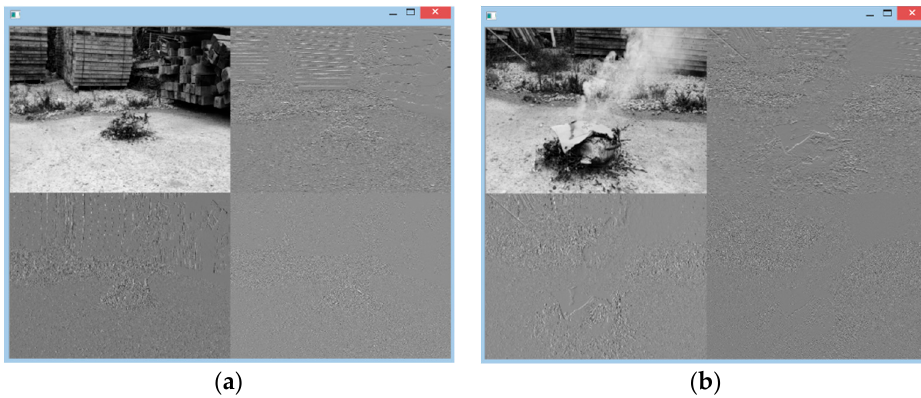
Figure 6. Single level of wavelet transform results, ( a ) non-smoke sub-images and ( b ) smoke sub-images.